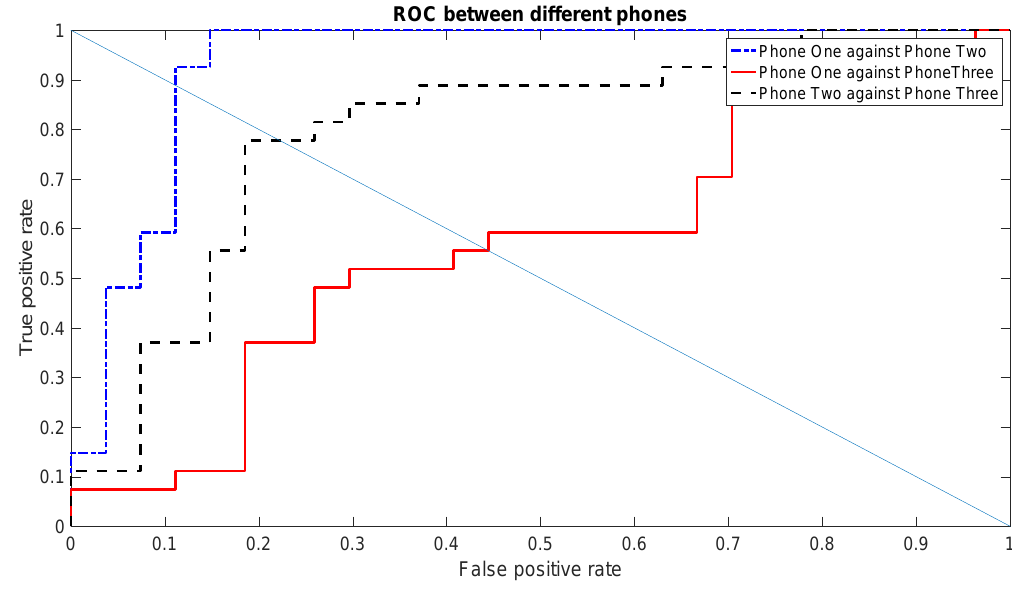
Figure 12. ROCs among different phones using the first scenario for Gyroscope X for a single day’s data in the second set of measurements.